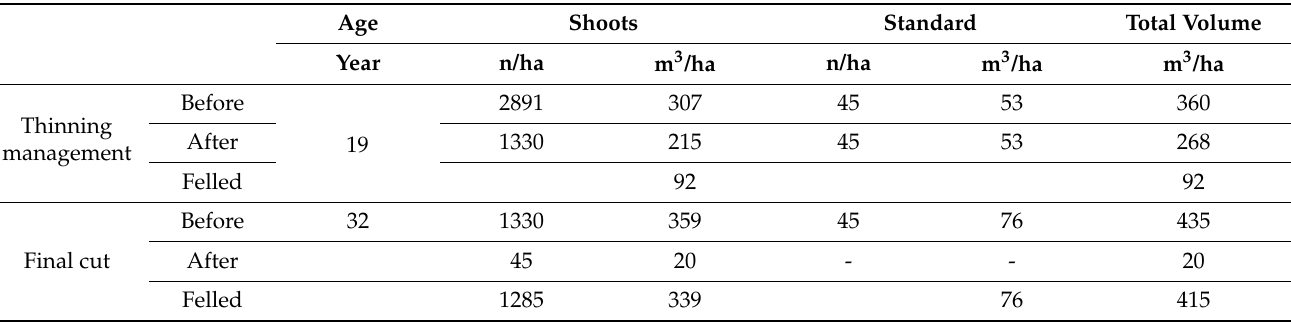
Table 1. Forest section management